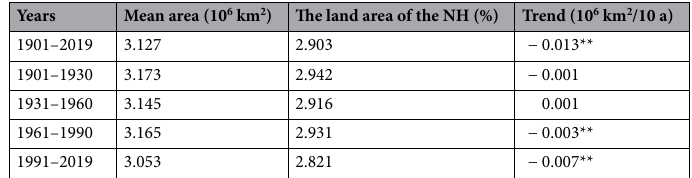
Table 3. The mean area variation of the cold regions in the Qinghai-Tibetan Plateau from 1901 to 2019. “*” and “**”: P < 0.01 and 0.001, respectively.